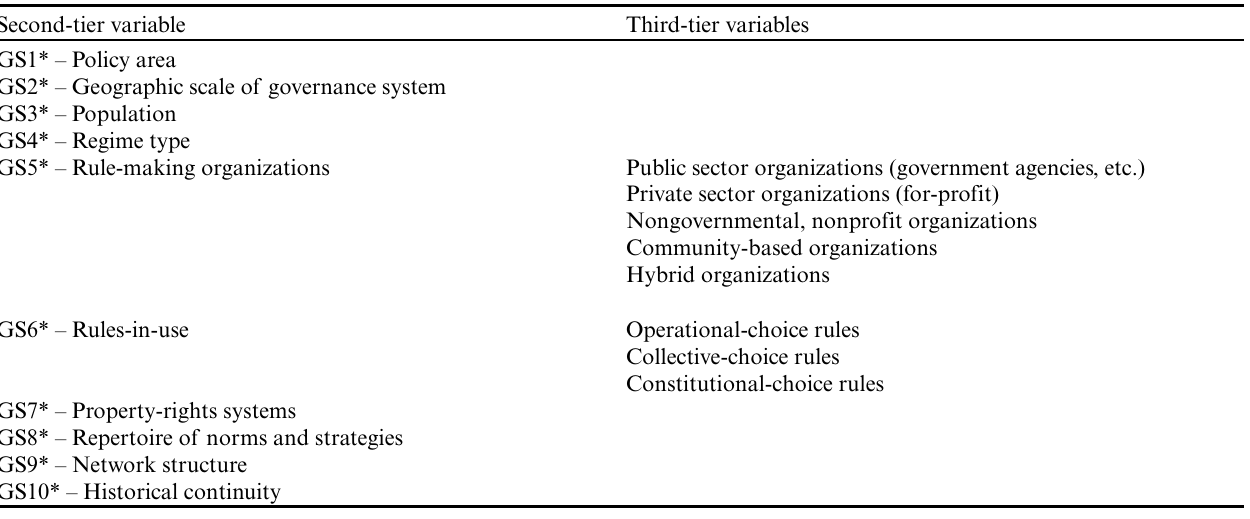
Table 2. Alternative list of second-tier properties for governance systems